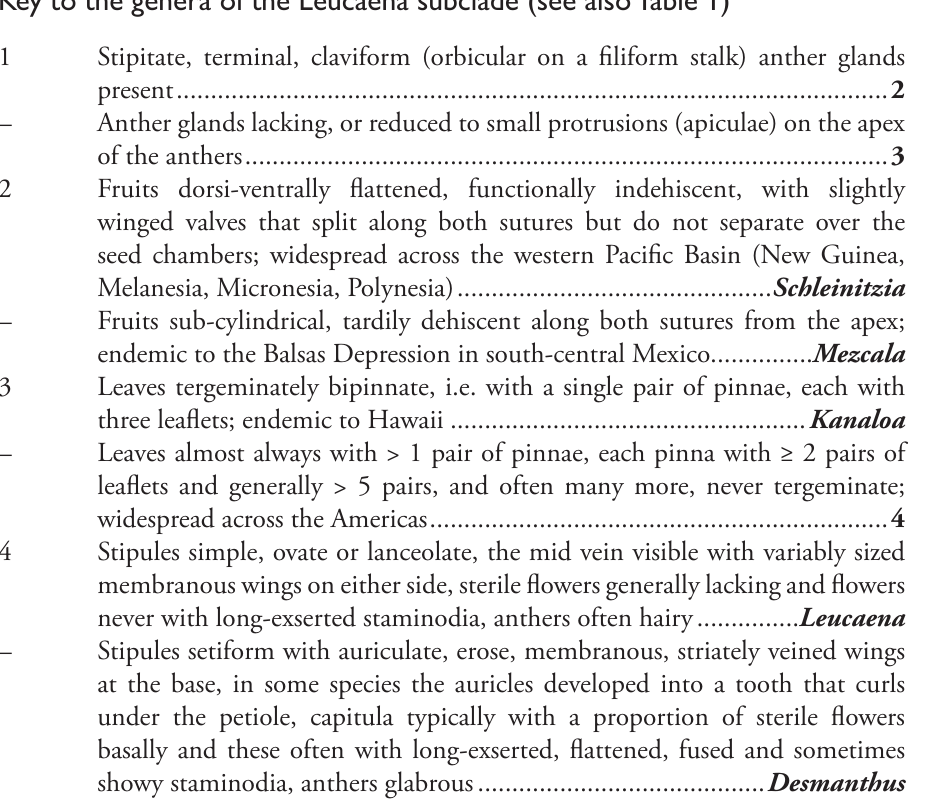
Stipules setiform with auriculate, erose, membranous, striately veined wings at the base, in some species the auricles developed into a tooth that curls under the petiole, capitula typically with a proportion of sterile flowers basally and these often with long-exserted, flattened, fused and